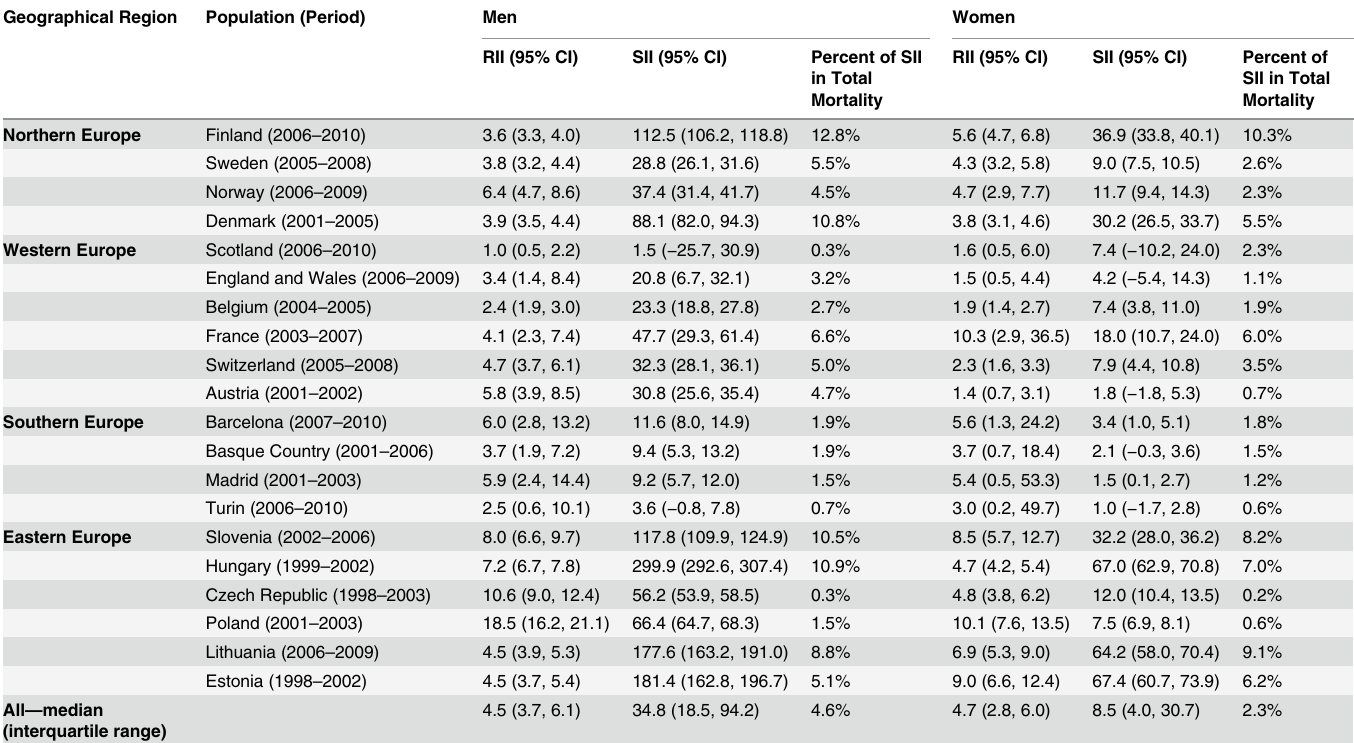
Table 4. Age-adjusted educational inequality in mortality from alcohol-related causes in the most recent observed period, by population and sex, for individuals aged 35 – 79 y. Geographical Region Population (Period)